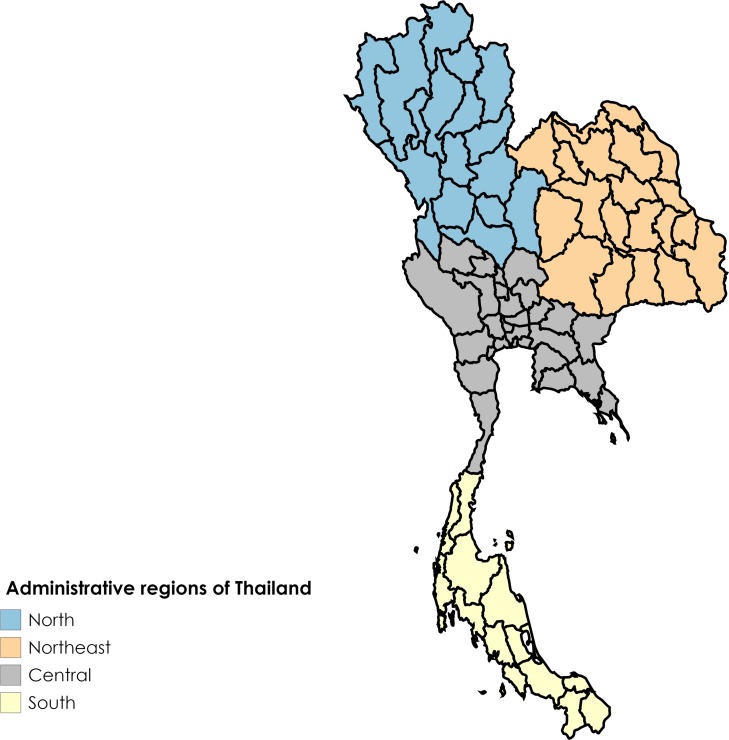
Administrative regions of Thailand [National Statistical Office, Ministry of Information and Communication Technology; reprinted from mapchart.net under a CC BY license, with permission from Minas Giannekas original copyright 2019].